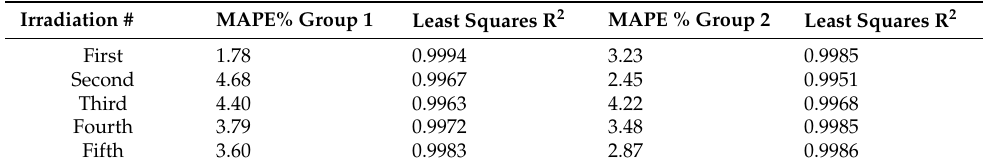
Table 5. Linearity values for Formulation 3 (Groups 1 and 2) for five successive irradiations. The mean average percent error (MAPE) calculation includes cuvettes dosed with 1–10 Gy. The R 2 coefficient of linearity is also included.